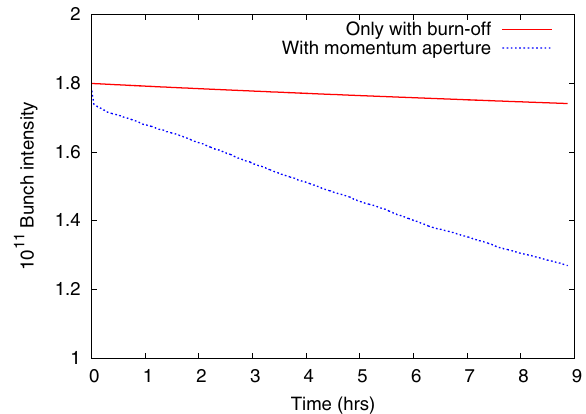
FIG. 19. Evolution of bunch intensity from multiparticle simulation. Momentum aperture 6 × 10 − 4 is applied. Initial beam parameters similar to Fill 16697 are used.